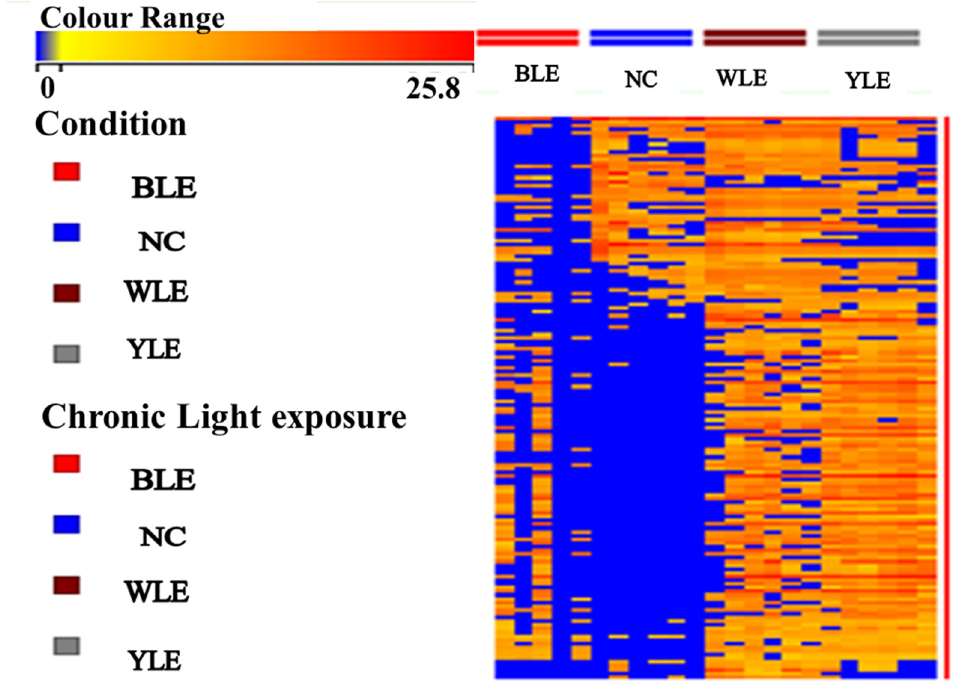
Figure 3. Hierarchical clustering analysis (HCA) by R version (version 3.6.3). HCA of the significant metabolites across the group were plotted in heat map. The color gradient illustrates the fold change (Fc3.1) in protein abundance between the four groups. The ratio of precursor to metabolite for each sample value is calculated, and significant metabolites are selected and plotted. Rows represent control (NC), blue light exposure (BLE), white light exposure (WLE), and yellow light exposure (YLE) groups, and metabolic column ratio. The color spectrum toward red represents the upregulation of metabolites and blue represents the downregulation, respectively. A clear separation of the metabolite’s alteration in the three exposure and control group conditions was observed, and the alteration becomes more obvious when significant metabolites have been considered.